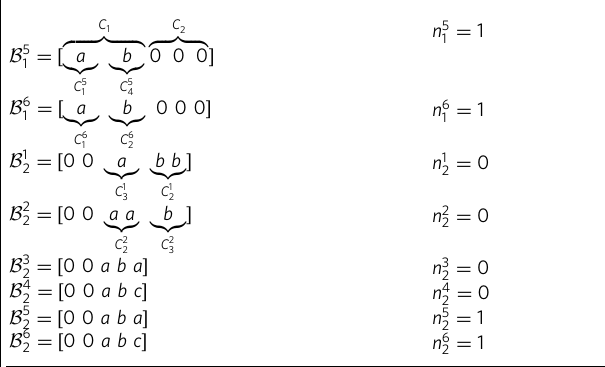
Table 1 Breaking vectors and intertwining indices.